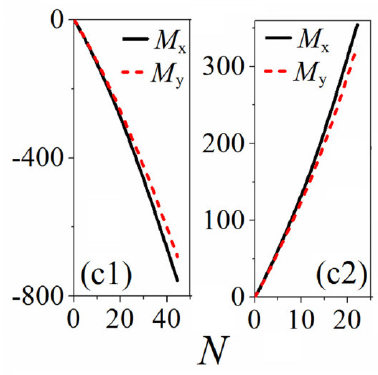
Figure 10. Effective mass for isotropic (left) and anisotropic (right) 2D GS under kick in the x and y directions